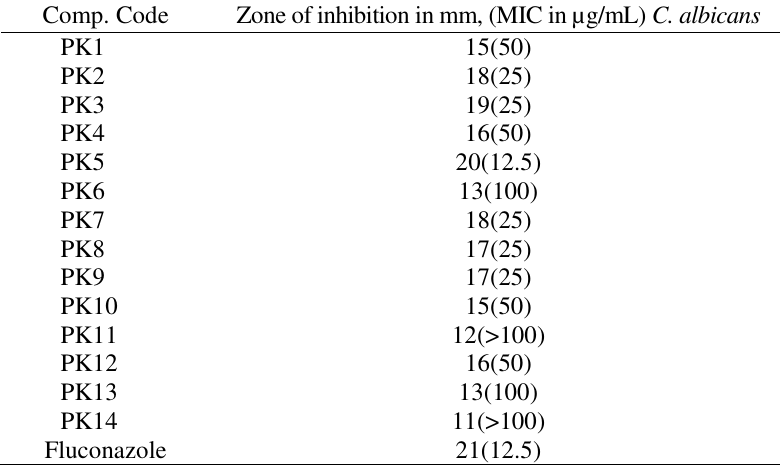
Table 4. Antifungal activity of the synthesized compounds Comp.